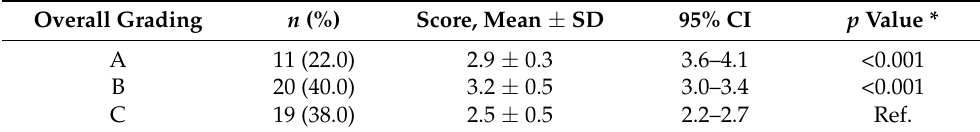
Table 3. Average cleansing scores according to overall clinical grading of validation cases.